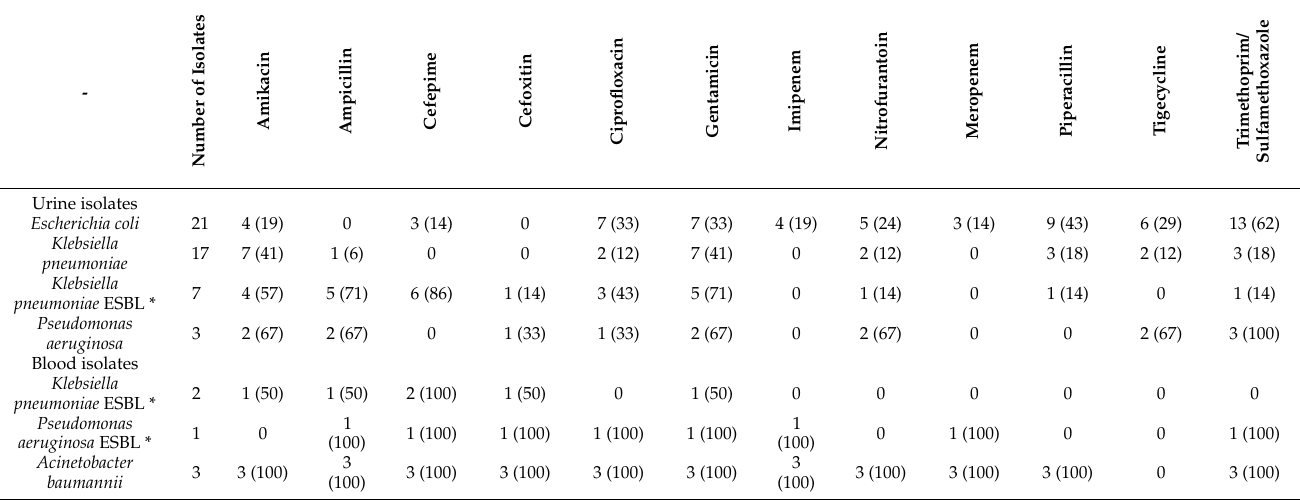
Table 2. Resistance profiles of Gram-negative bacteria isolated from positive urine and blood cultures towards a set of commonly used antibiotics in neonatal intensive care unit (NICU).